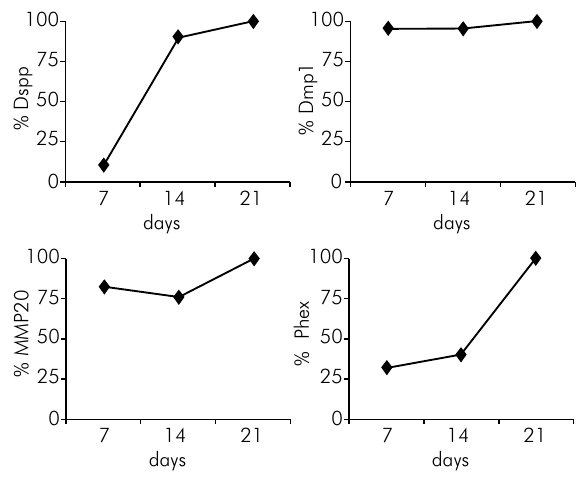
Figure 4. The fold increase in the expression levels of the (+) group compared to the (-) group for Dspp, Dmp1, MMP20 and Phex at the 7 th , 14 th and 21 th culture days (The relative percentages of expression were shown in relation to the highest value as 100% after normalization against β -actin).